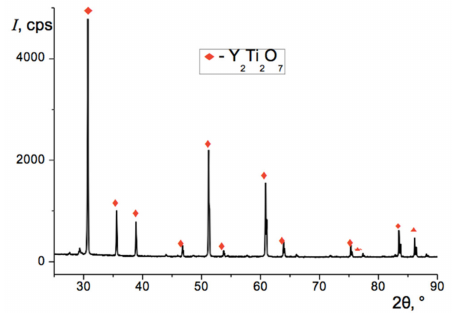
Figure 2. Di ff raction pattern of the sample after total 17 h of calcination at 1150 ◦